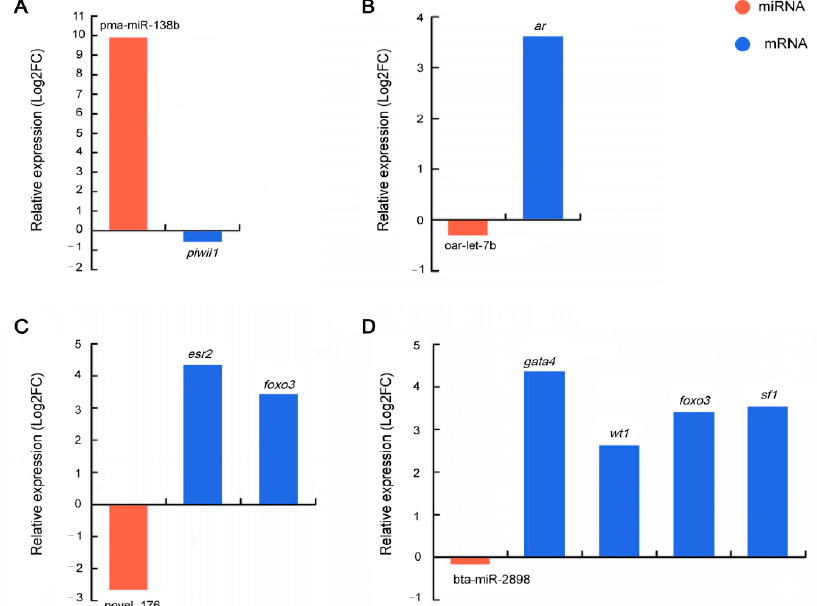
Figure 3. Four key sex-biased miRNAs and their target genes verified by qPCR. ( A ): pma-miR-138b regulated piwil1 . ( B ): oar-let-7b regulated ar . ( C ): novel_176 regulated esr2 and foxo3 . ( D ): bta-miR- 2898 regulated gata4 , wt1 , foxo3 , and sf1 .